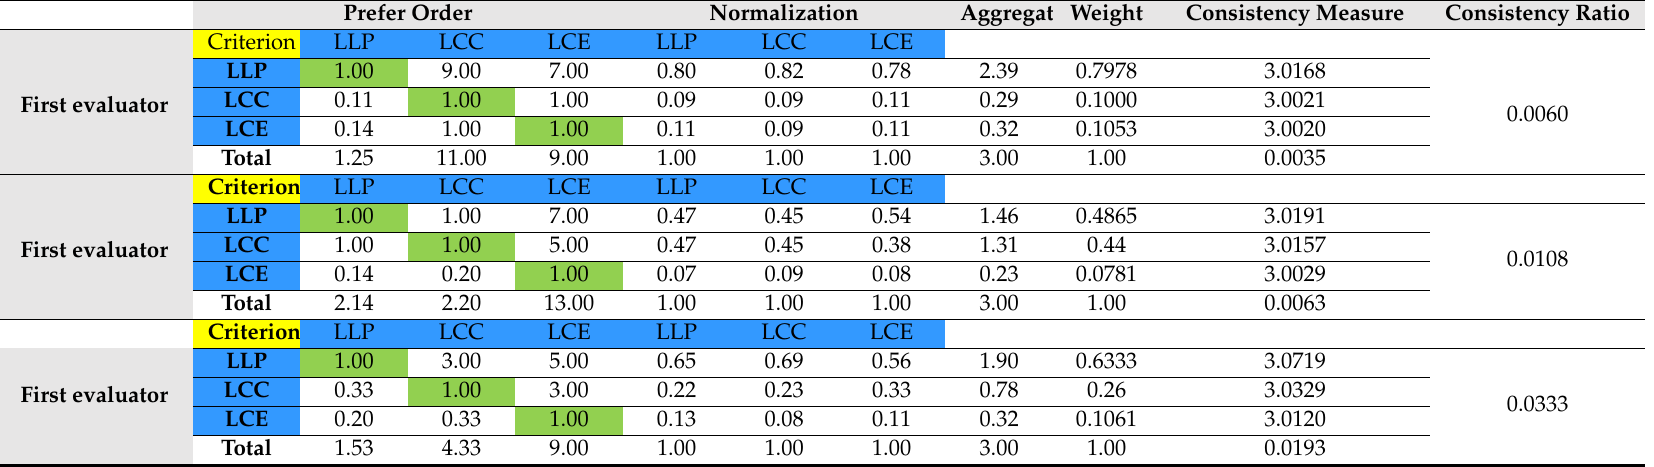
Table 5. AHP processing matrix to calculate the weights of criteria with consistency ratio values. Prefer Order Normalization AggregationWeight Consistency